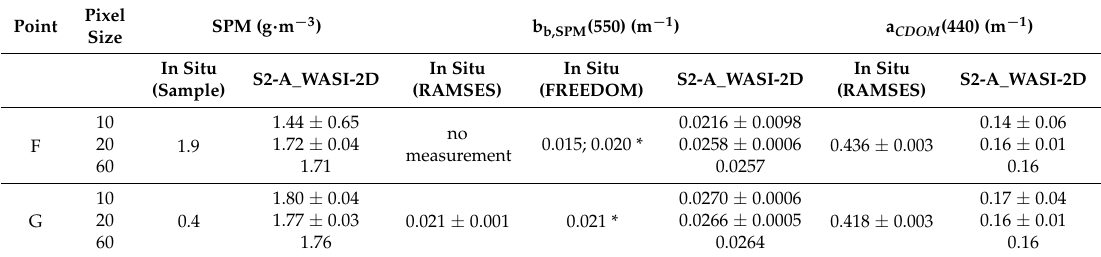
Table 2. Comparison of in situ and S2-A (WASI-2D) results in optically deep water. Term in parentheses indicates in situ data source. SPM values originate from water samples taken the day before image acquisition. Mean and standard deviation of 5 × 5 respectively 3 × 3 pixel environment were calculated for 10 m and 20 m pixel size, respectively, and reflect spatial variability. The values of the 60 m pixels correspond to GPS coordinates. Errors for in situ (RAMSES) are derived from inversion and reflect variability during a measurements series. SPM (g · m − 3